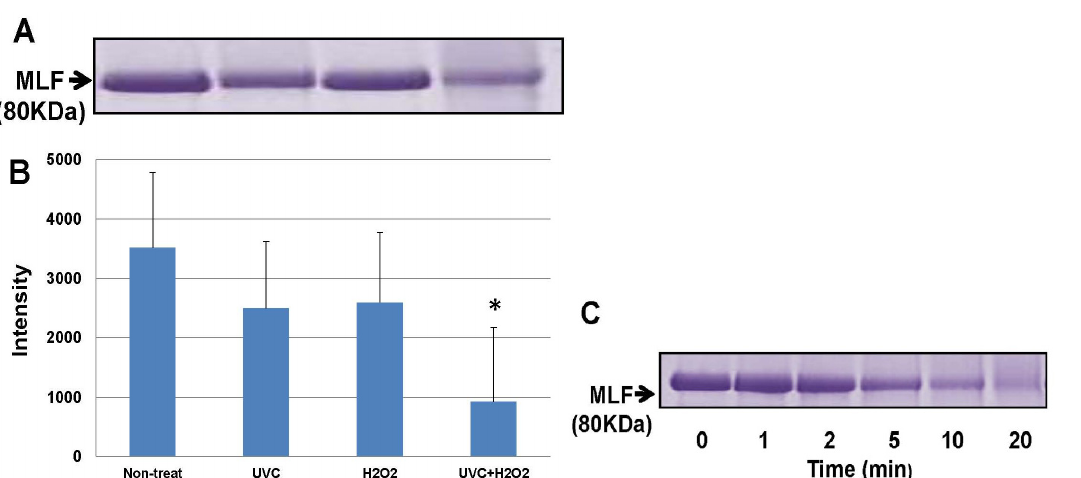
Figure 5. SDS gel electrophoresis of LF and apo-LF solutions exposed to UV irradiation O . ( A ) CBB stained for native LF (MLF) in SDS-polyacrylamide gel. Lane 1, with H 2 2 non-treated; lane 2, UV (254 nm) irradiated for 10 min without H without UV irradiation; and lane 4, UV irradiated for 10 min with H the stained bands demonstrated that 80-kDa native LF (MLF) remains intact under the conditions described in ( A ). Data are presented as the mean ± S.D. of triplicate determinations. * p < 0.05 compared to the non-treated control values obtained was considered as a statistically significant difference; ( C ) Coomassie brilliant blue (CBB) stained in SDS-polyacrylamide gel for native LF (MLF) exposed to UV (254 nm) irradiation O for different lengths of time. Lanes from left to right: 0, 1, 2, 5, 10 and 20 with H 2 2